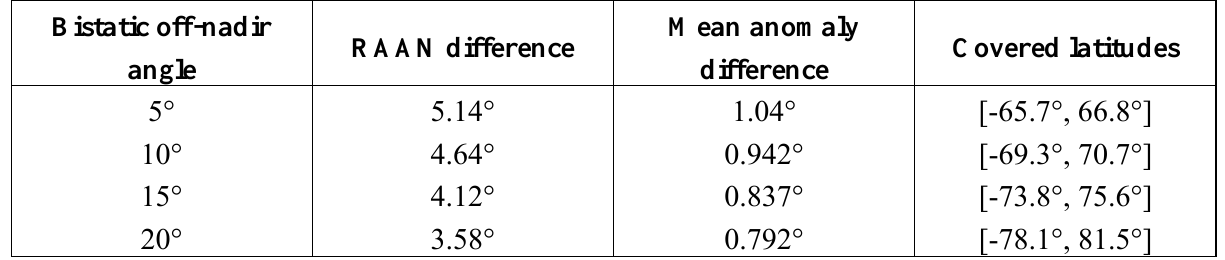
Table 2. Latitude intervals where satisfactory bistatic baselines and angles are achieved during ascending phase in pendulum configurations for four off-nadir angles of the bistatic